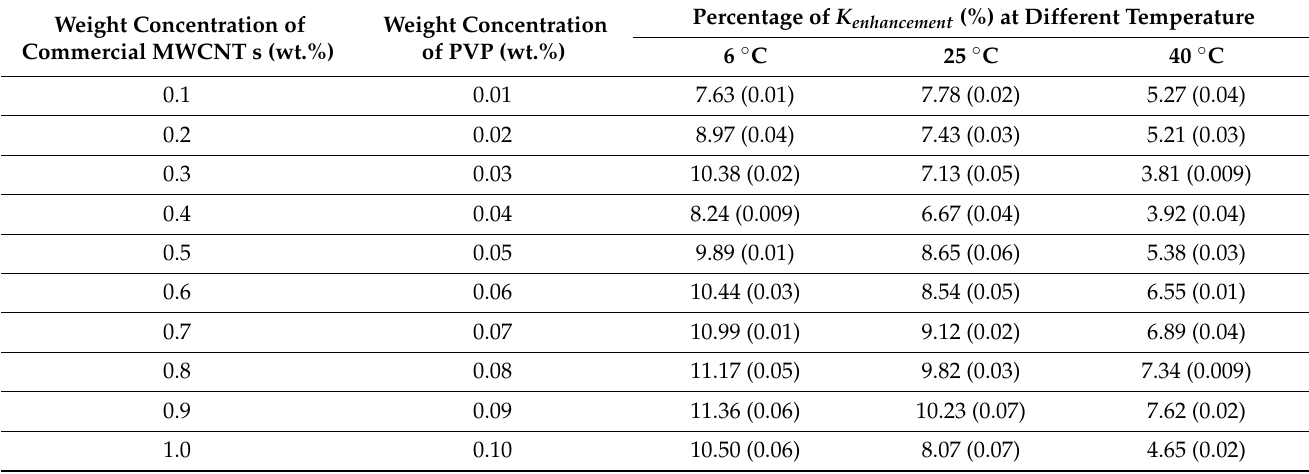
Table 6. Thermal conductivity enhancement of commercial MWCNTs nanofluid with PVP. Weight Concentration of Weight Commercial MWCNT s (wt.%)